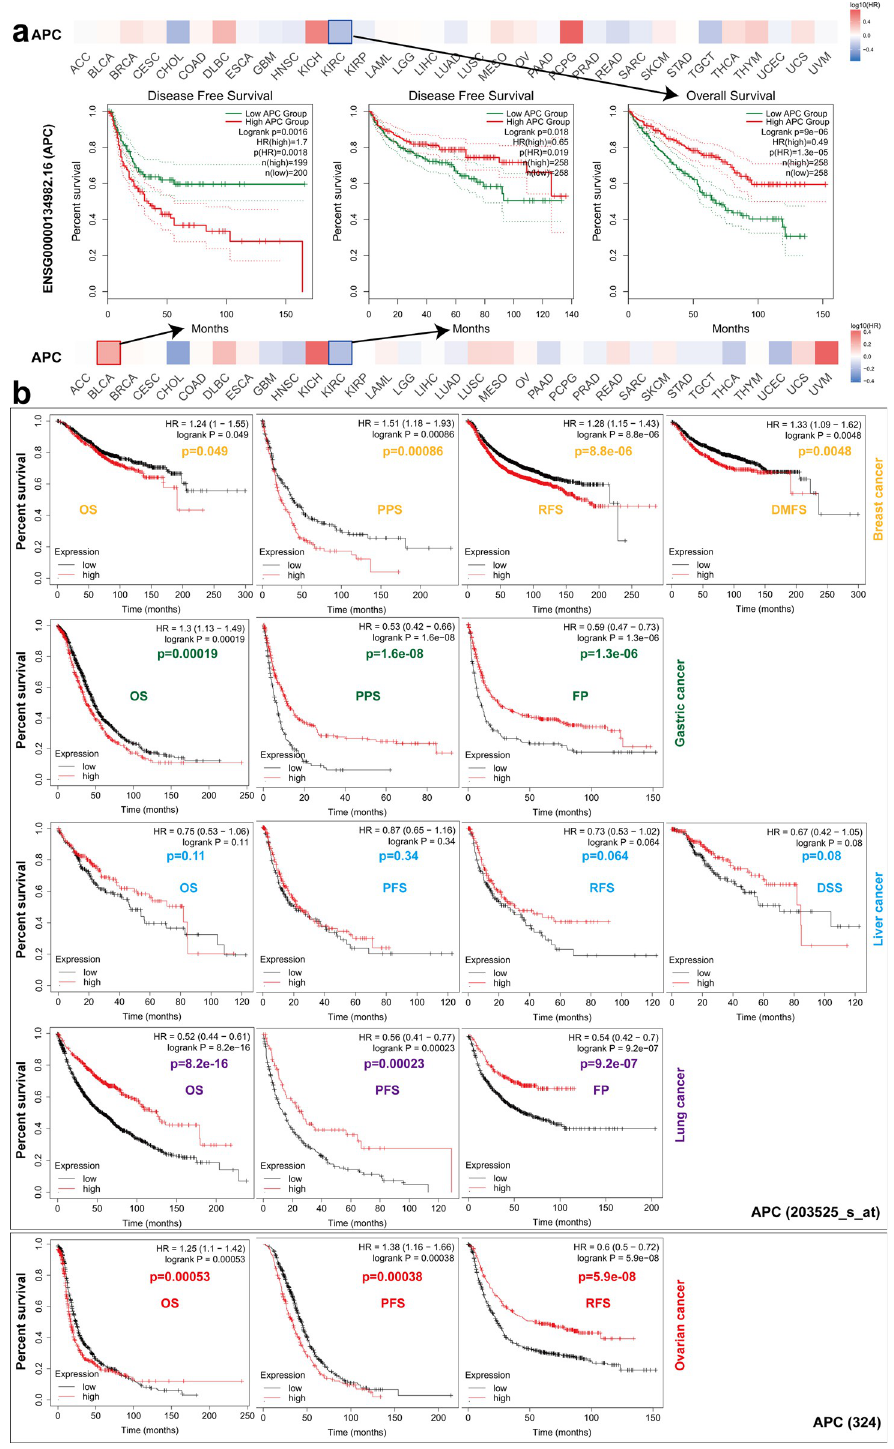
Fig 5. Survival as related to the APC gene. (a) The overall survival (OS) and disease-free survival (DFS) analyses on APC gene expression by using the web of GEPIA2. (b) Kaplan-Meier curves of survival analyses with logging the website “http://kmplot.com/analysis/” with setting “autoselect best cutoff”. RFS, relapse-free survival.